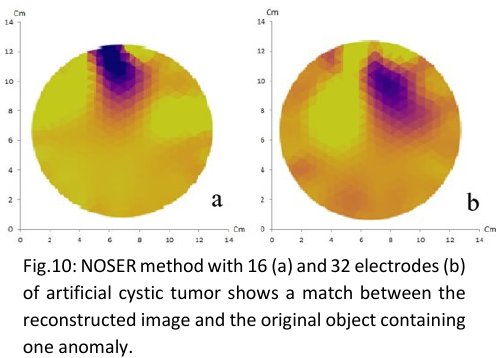
Fig.7: A water-filled balloon was used to mimic a cystic lesion. This ultrasound image demonstrated the cystic lesion as a well-defined, oval-shaped anechoic area with posterior enhancement.